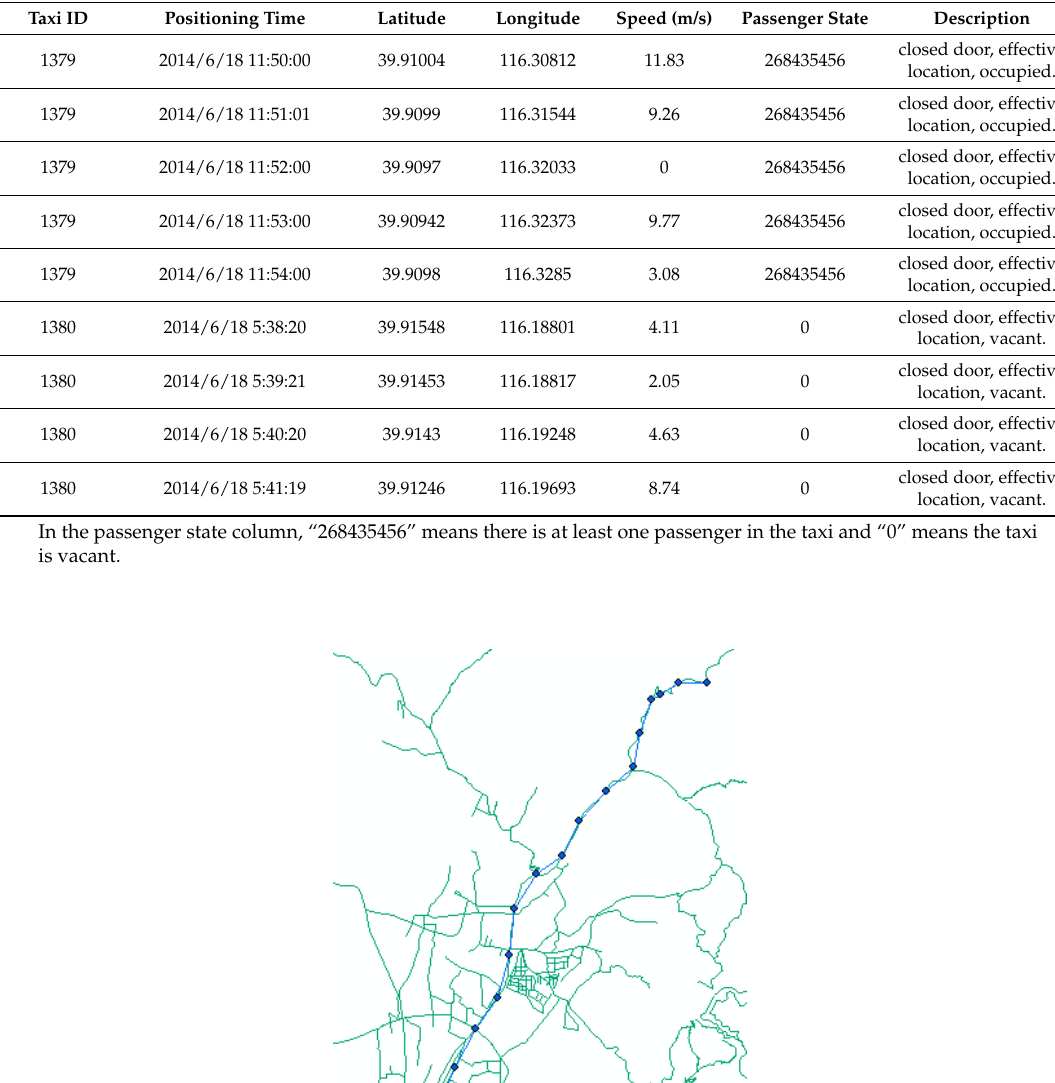
Table 2. Example of taxi GPS data.